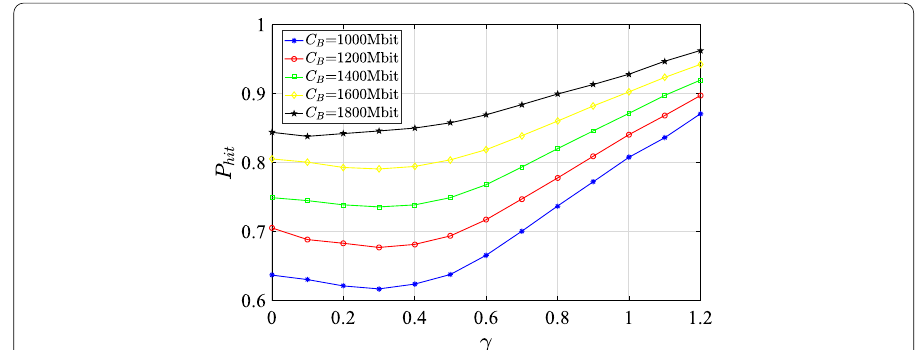
Fig. 6 The effect of γ on P hit under different C B